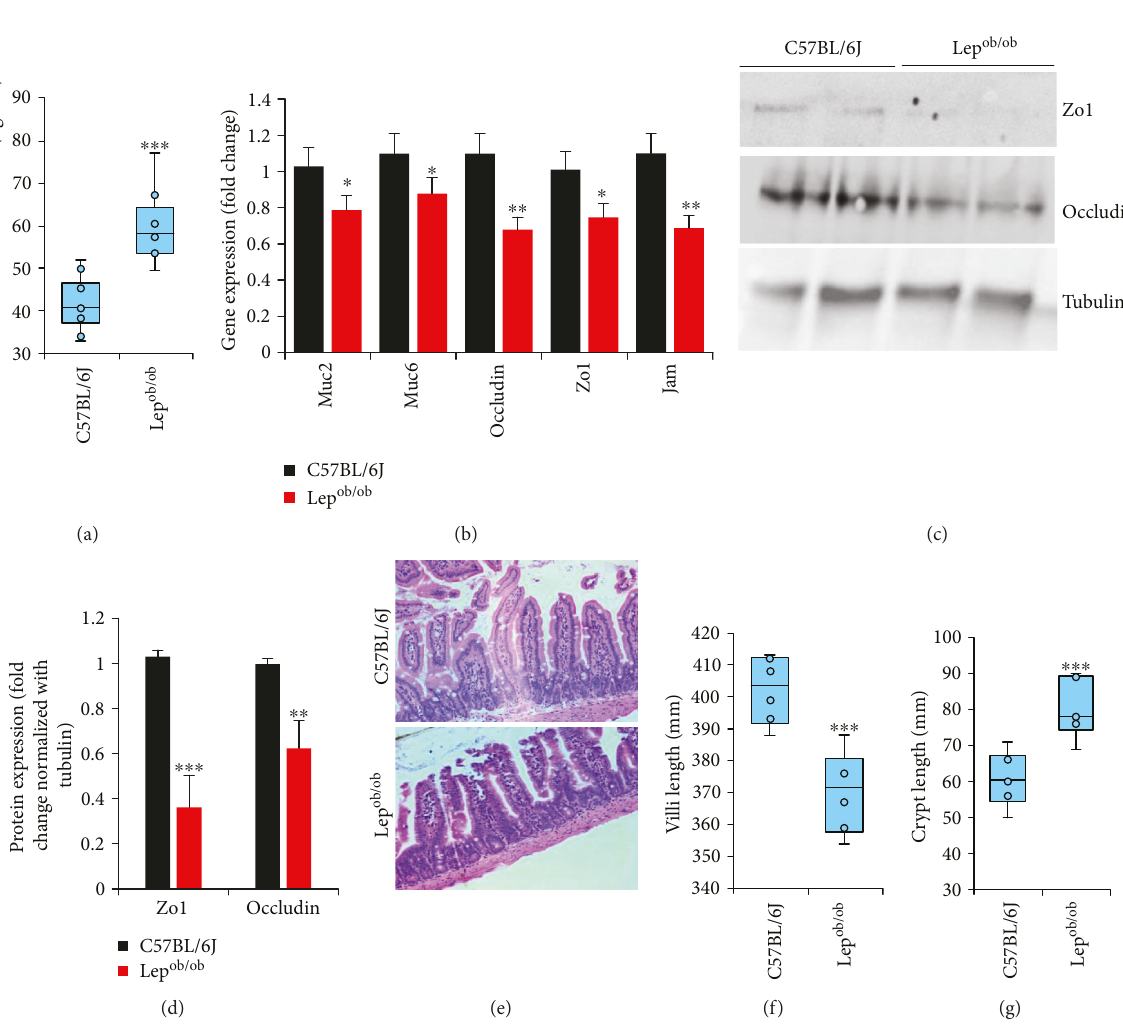
Figure 1: Gut permeability and intestinal structural changes are associated with mucin-tight junction formation independent of dietary di ff erences. (a) Gut permeability (di ff usion of FITC-dextran; 4 KDa from gut to blood) increased obese mice compared to B6 control. (b) Expression of mucin (Muc2 and Muc6) and tight junction- (occludin-, Zo1-, and Jam-) forming genes signi fi cantly decreased in Lep ob/ob intestine than B6 mice. (c, d) Western blot analyses of Zo1, occludin, and tubulin in intestinal tissues. (e – g) Hematoxylin and eosin (20x) staining for the small intestine (ileum) (e), decreased length of villi (f), and increased crypt (g) in obese mice. Values presented here are average ± SEM. p values are de fi ned as ∗ < 0 05 , ∗∗ < 0 01 , and ∗∗∗ < 0 001